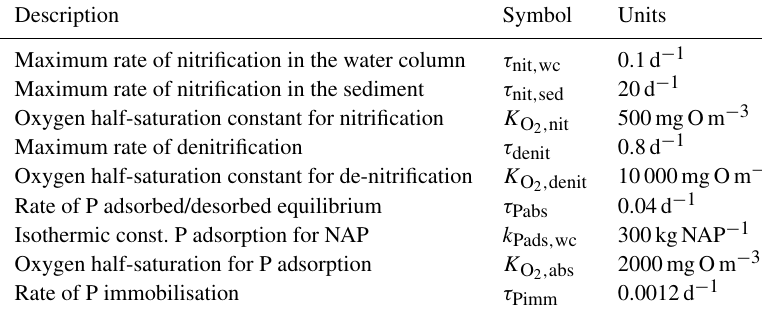
Table 35. Constants and parameter values used in the sediment inorganic